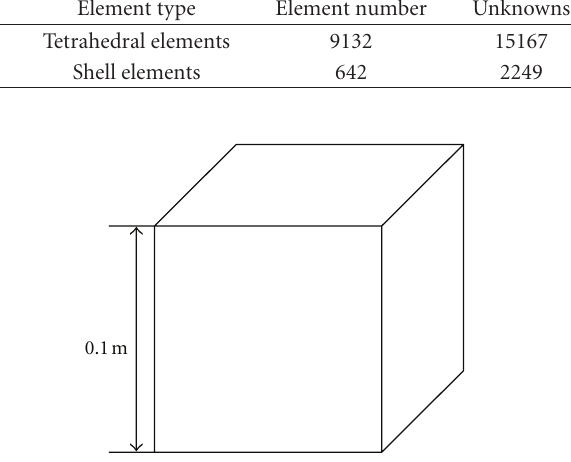
Figure 7: Conducting cube coated by thin material.